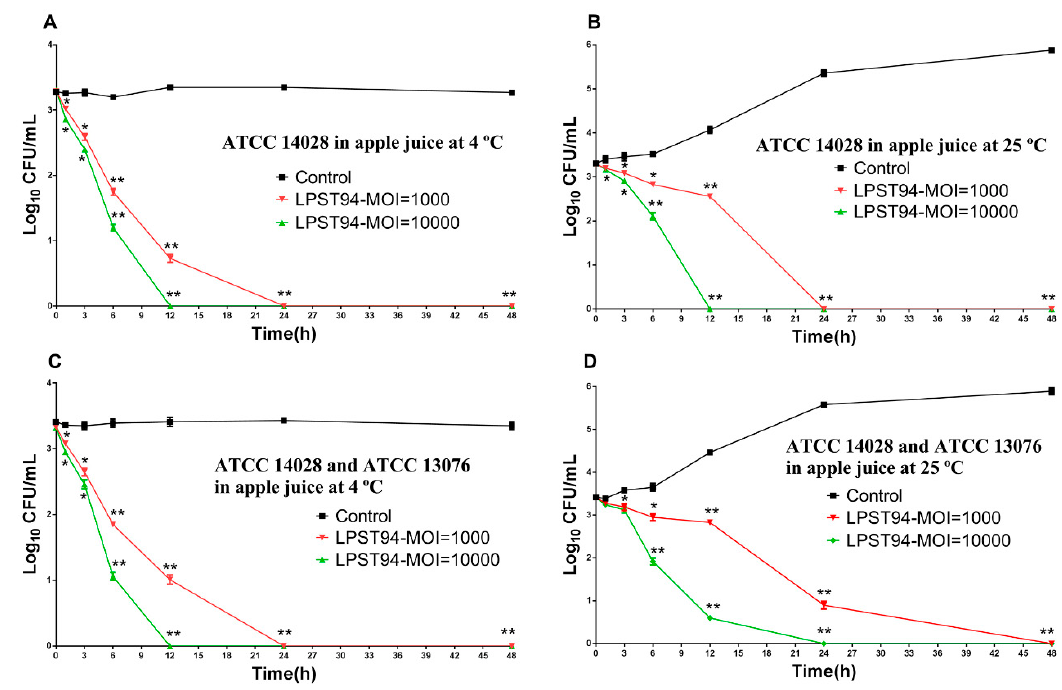
Figure 5. E ff ectiveness of phage LPST94 in reducing the S. Typhimurium ATCC 14028 and S. Enteritidis ATCC 13076 in apple juice. ( A ) E ff ect of phage LPST94 on growth of S. Typhimurium ATCC 14028 in apple juice at 4 ◦ C, ( B ) E ff ect of phage LPST94 on growth of S. Typhimurium ATCC 14028 in apple juice at 25 ◦ C, ( C ) E ff ect of phage LPST94 on growth of Salmonella mixture ( S. Typhimurium ATCC 14028 and S. Enteritidis ATCC 13076) in apple juice at 4 ◦ C, and ( D ) E ff ect of phage LPST94 on growth of Salmonella mixture ( S. Typhimurium ATCC 14028 and S. Enteritidis ATCC 13076) in apple juice at 25 ◦ C. Values represent mean with standard deviation of three determinations. ** Significance of p < 0.01; * Significance of p < 0.05.